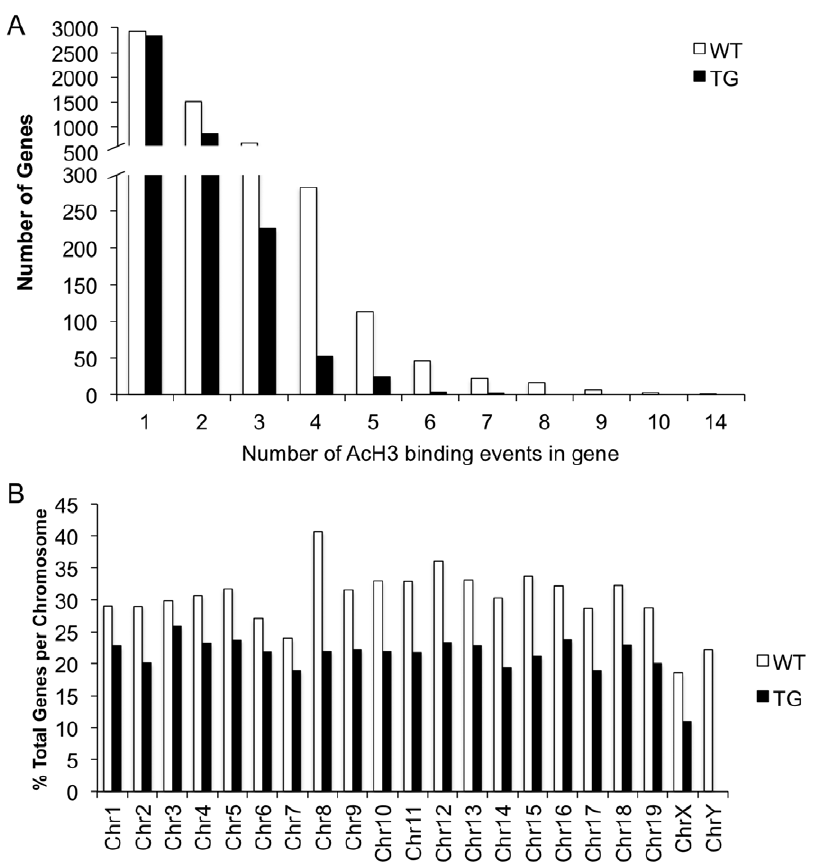
Figure 2. AcH3 binding patterns within a gene and across chromosomes are diminished in TG striata. (A) Distribution of the number of AcH3 binding events in WT and TG striata expressed as probes bound per gene. (B) Distribution of AcH3-gene associations for each chromosome in WT and TG striata expressed as a percentage of AcH3-bound genes per total genes on each chromosome. White bars, WT; black bars, TG.